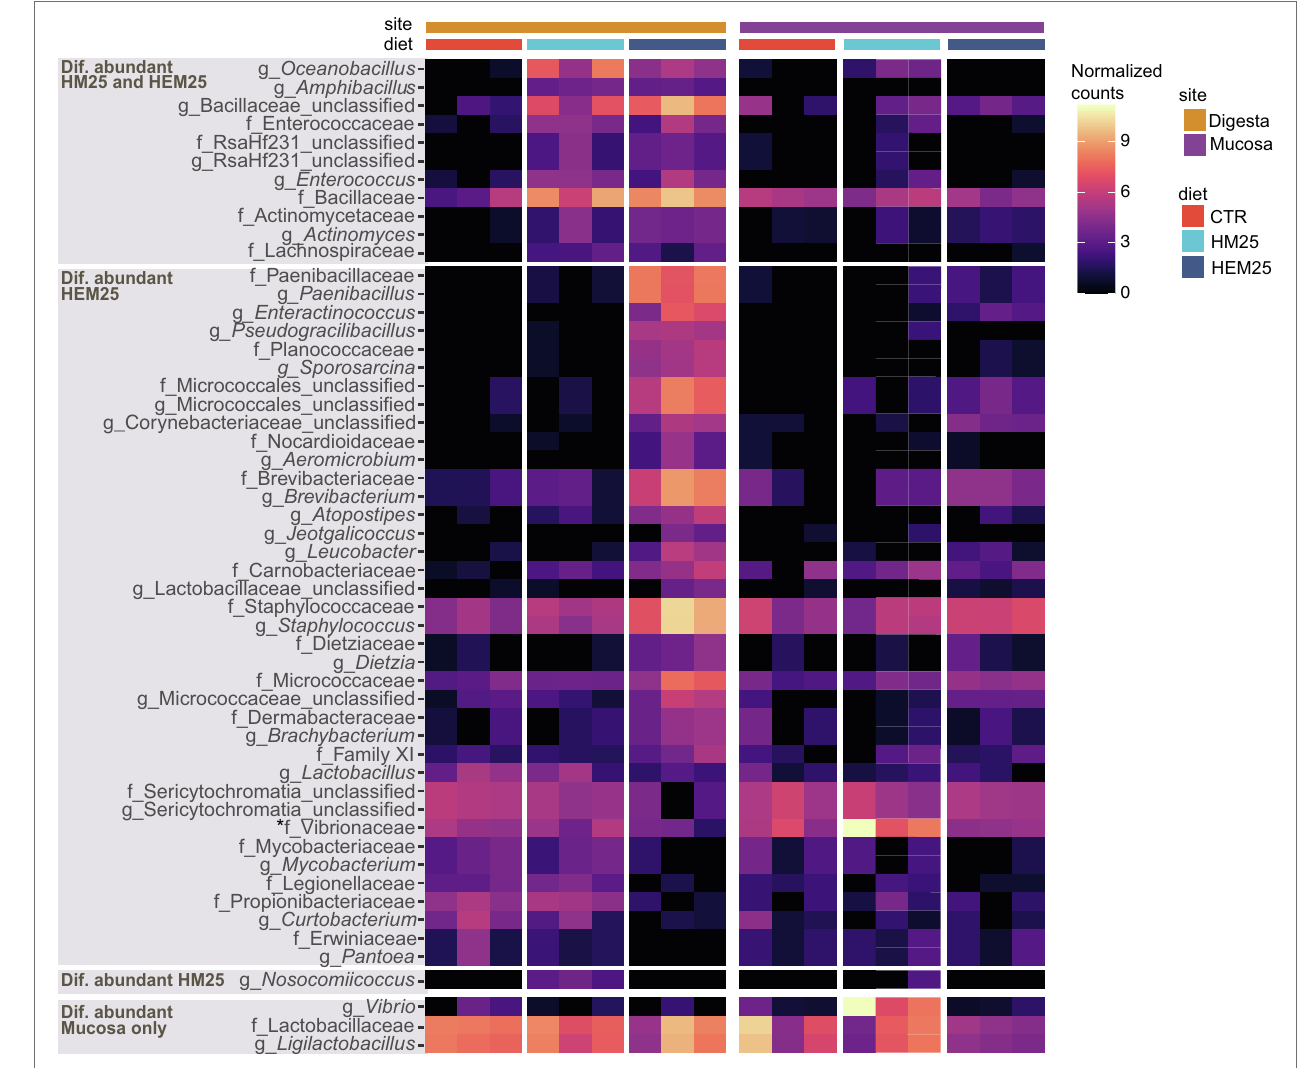
FIGURE 4 | Genus and Family-level shifts induced by HI-based diets. Heat map showing transformed (log2 base) normalized read counts of genus and family-level taxa found to be differentially abundant in the guts of fish fed HM25 vs. a CTR diet, or fed a HME25 vs. CTR diet, based on DESeq2 analysis (adjusted value of p < 0.05, Wald test followed by Benjamini–Hochberg correction for multiple testing). Top three panels show taxa differentially abundant in digesta-originating samples or in both digesta and mucosa samples (marked with an asterisk), while the bottom panel shows taxa differentially abundant in mucosa-originating samples